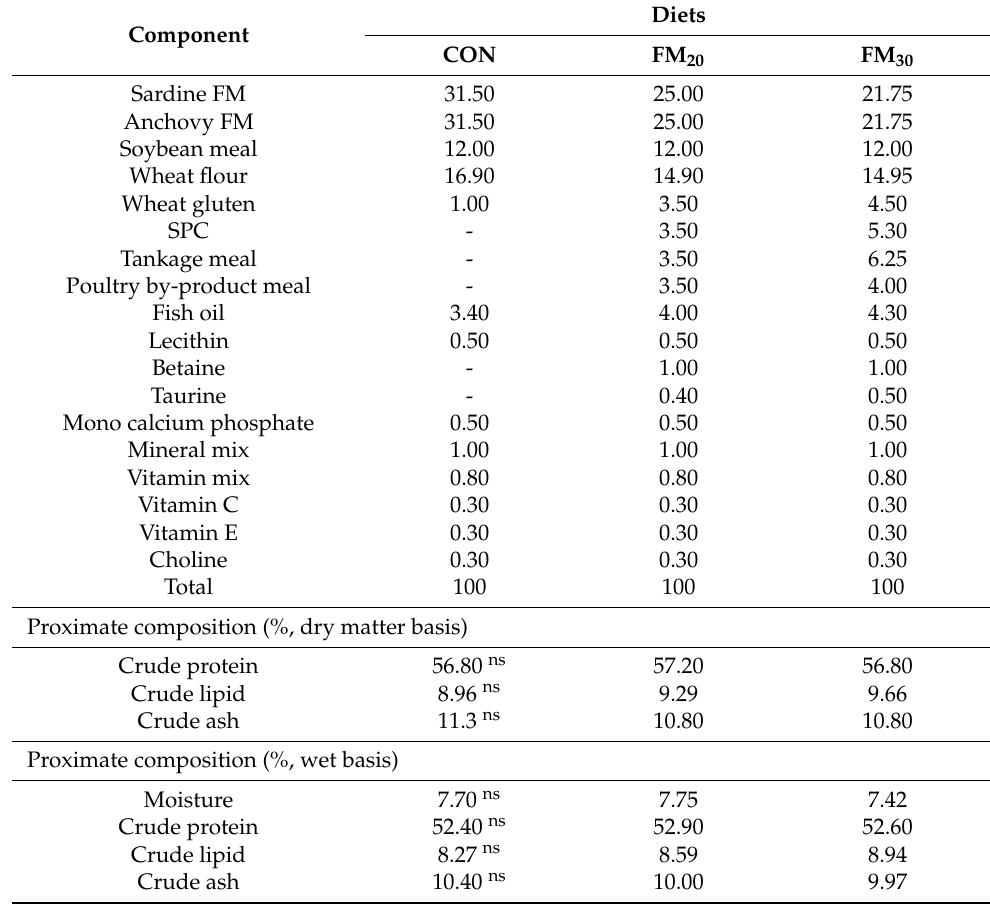
Table 1. Composition of the basal diet for the olive flounder Paralichthys olivaceus (%, dry matter